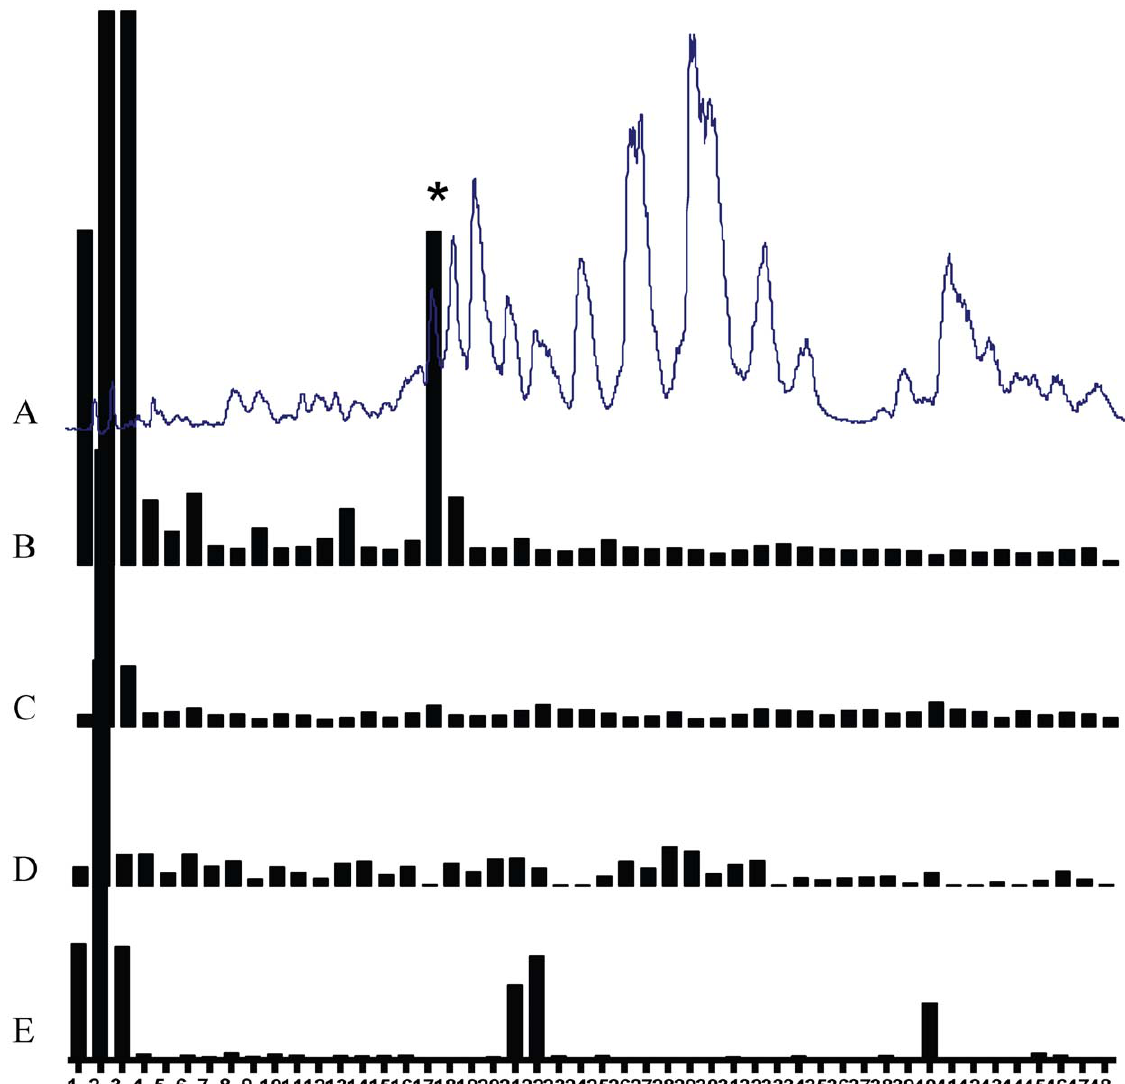
Figure 1. Fractionation of scorpion venom peptides and their opioid activities. (A) Scorpion venom was fractionated on a prep C18 column using a preparative HPLC system. One hundred milligrams of peptide samples were loaded per run. Fractions were eluted with a 50 min linear gradient from 5% B (ACN with 0.05% (v/v) TFA) to 35% B at a flow rate of 17 mL/min. The elution was monitored by MS. The activities of the fractions were detected in (B) d -expressing cells. (C) m -expressing cells. (D) k -expressing cells. (E) vector-expressing cells (negative control).